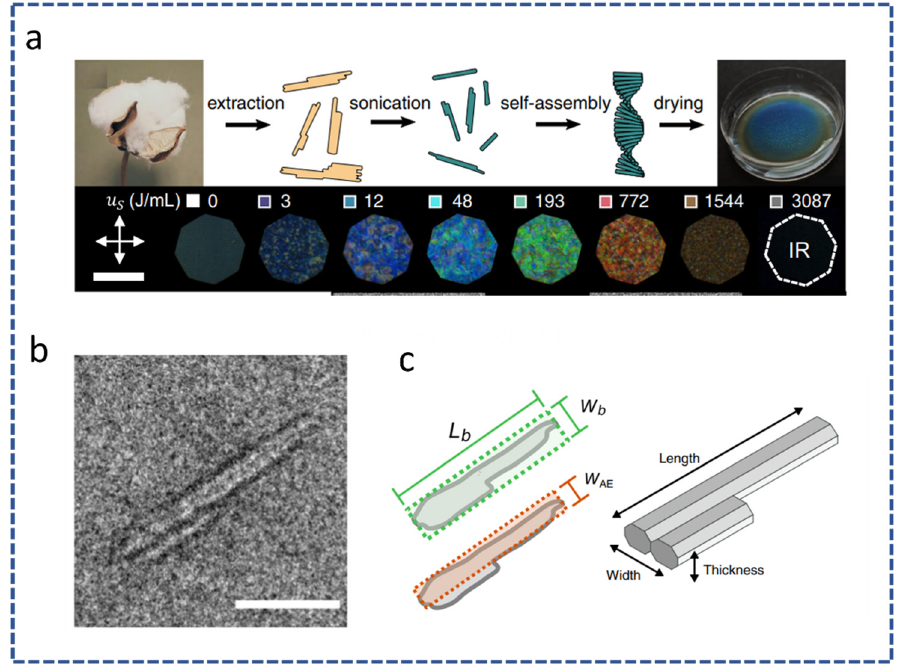
Figure 2. CNC bundle (slight agglomeration) as a chemical dopant (nucleus for chiral structure formation). ( a ) Sonication impact the formation of a chiral nematic structure that is structurally coloured as a function of sonication (Sonication energy has changed from 0 to 3087 J/mL). ( b ) Transmission electron microscopy (TEM) image of CNC bundle, showing slight agglomeration. ( c ) Schematic of CNC composite bundle as a model (bundles also artificially change the aspect ratio of CNCs). Adapted from Ref [37].